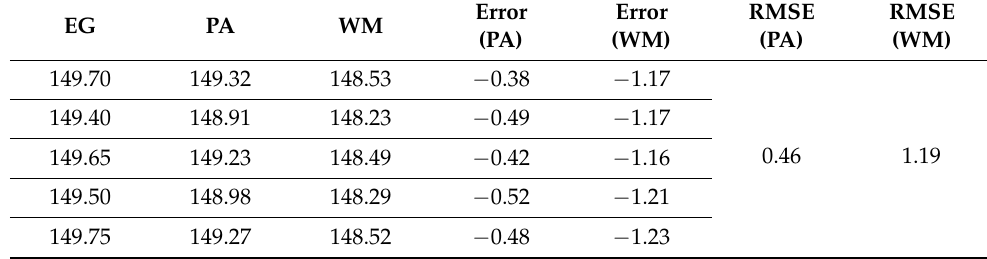
Figure 6. Measured angle using proposed algorithm (PA) and WitMotion (WM) (first trial).